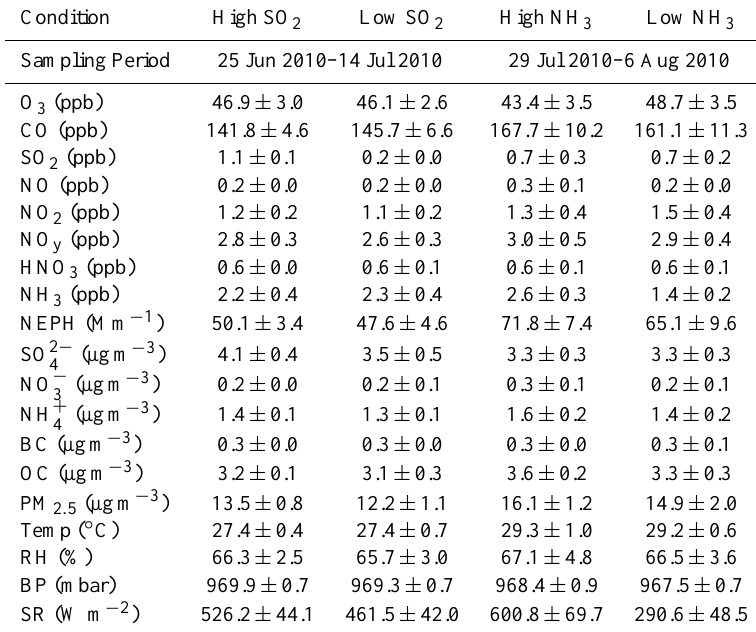
Table 1. Summary of average meteorological data and complementary collocated